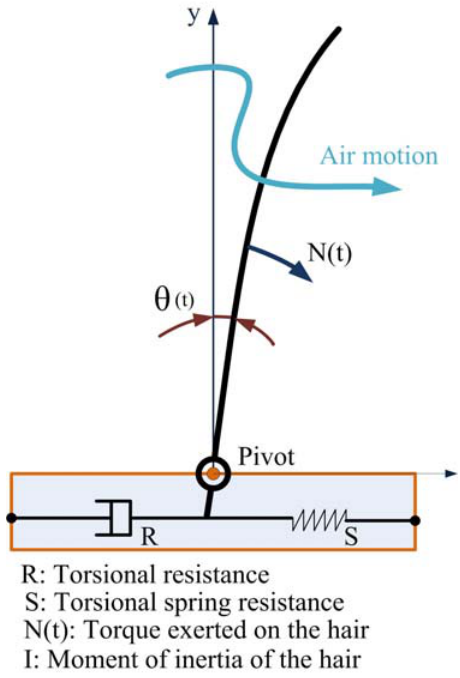
Figure 3. Inverted pendulum model of hair cell (Shimozawa et al .